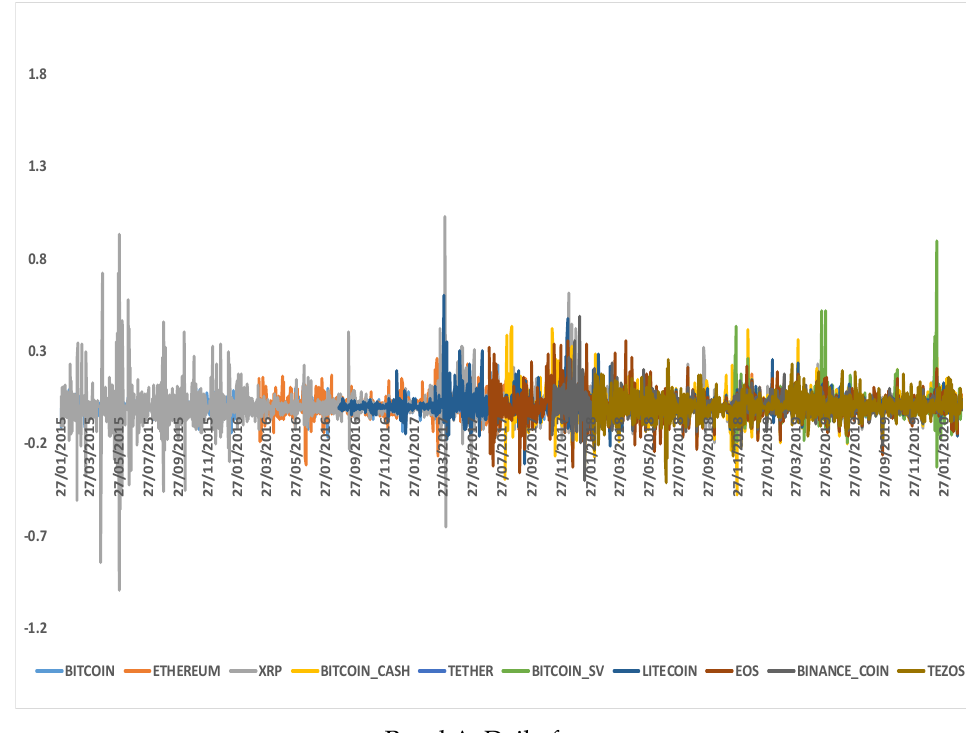
Panel A: Daily frequency